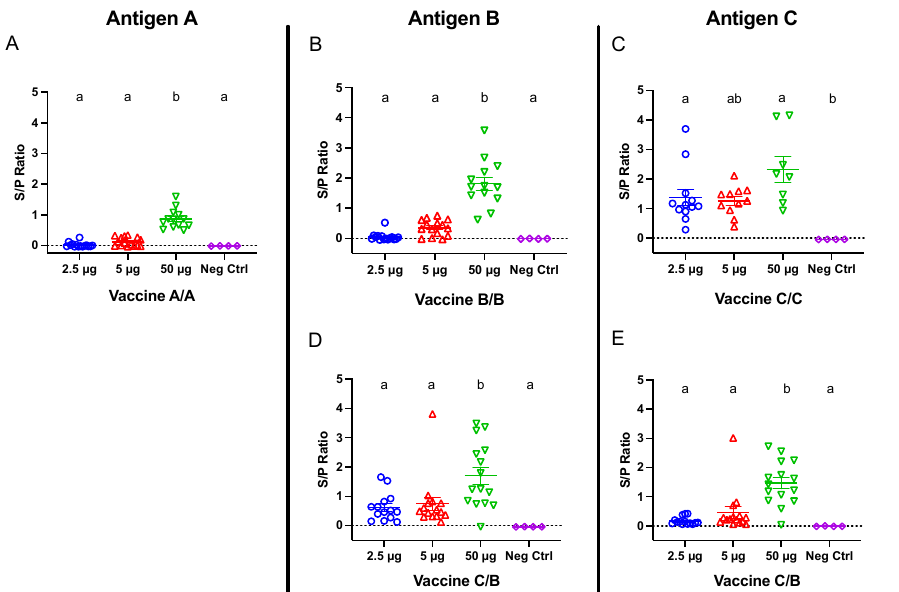
Figure 2. IgY titers in serum collected 21 days following the second vaccination for groups receiving ( A ) vaccine A/A, ( B ) vaccine B/B, ( C ) vaccine C/C, and ( D , E ) vaccine C/B combinations. Hens were inoculated twelve days apart. Antigen A-, B-, and C-coated plates were used for panels ( A ), ( B , D ), and ( C , E ), respectively. Error bars indicate the mean and standard error. Means without a common letter (a, b) are significantly different ( p < 0.05).